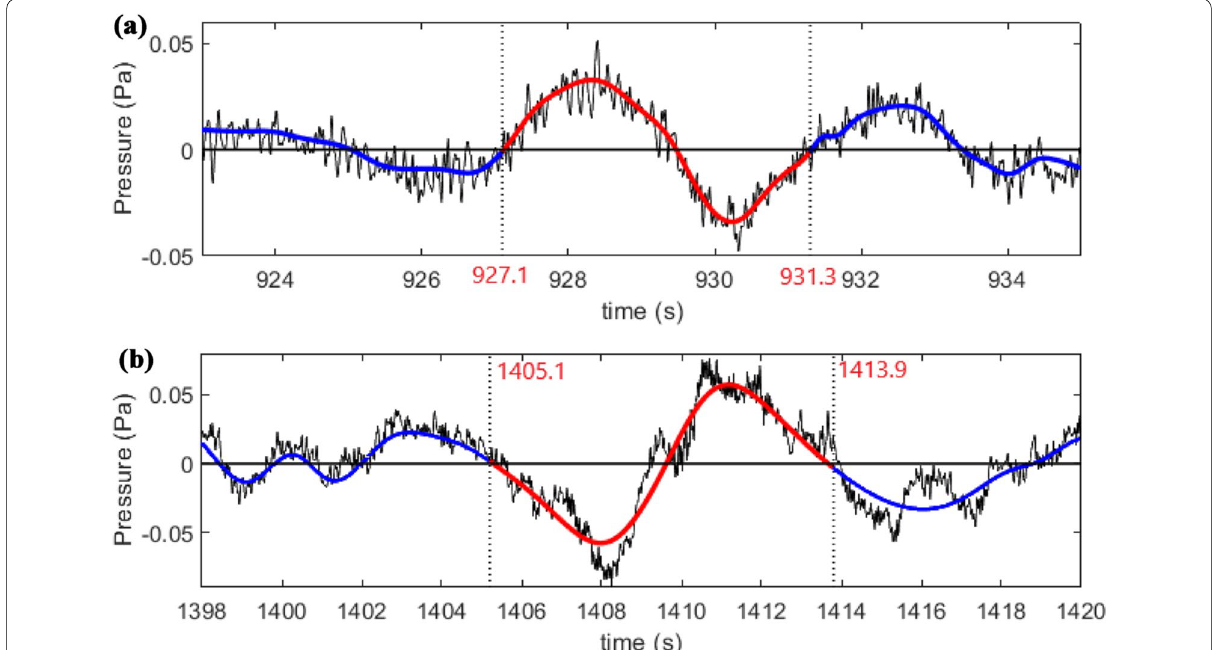
Fig. 7 Black curve is the original signal, the blue bold curve is the outline of signal from EMD procedure, the vertical straight line is the zero-pressure reference line, the vertical dotted line is starting time and ending time. a Period at the maximum amplitude of arrival A is 4.2 s; and b period at the maximum amplitude of arrival B is 8.8